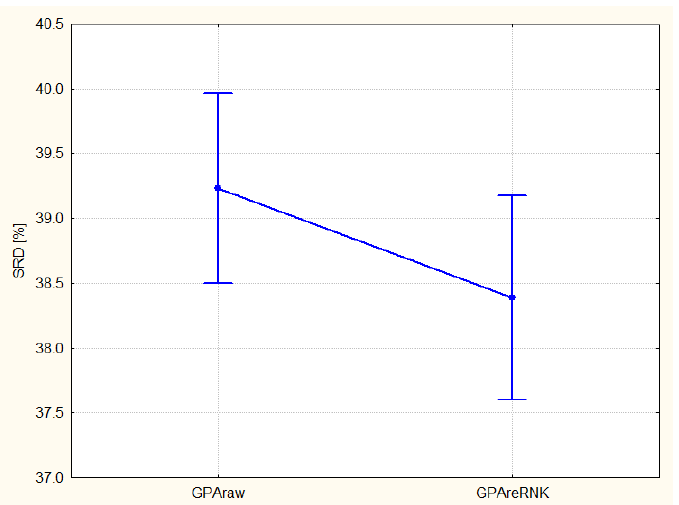
Figure 2. Comparison of coding options GPAraw – original GPA coding, GPAreRank (recoding to full rank) error bars represent 95% confidence interval. The variances are homogeneous according to the Levene’s test.